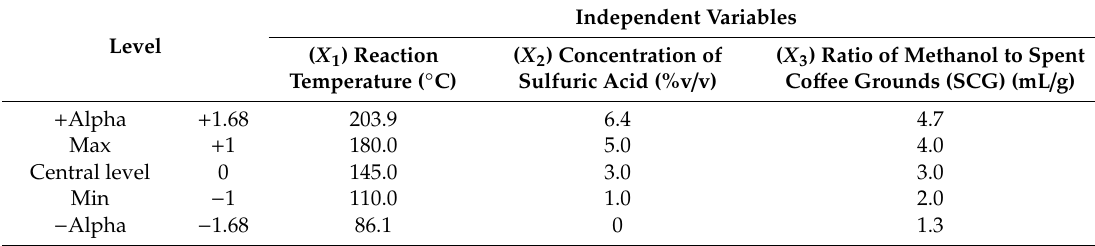
Table 1. Levels of independent variables.